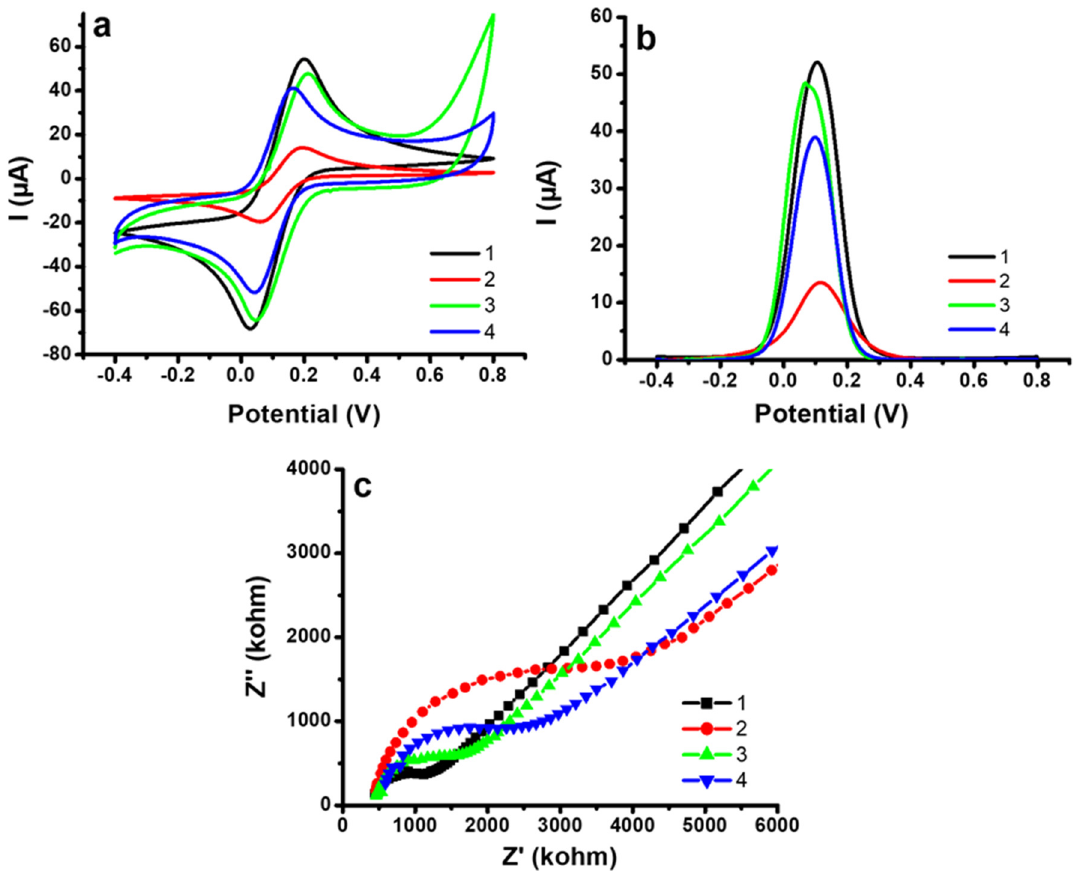
Figure 4. ( a ) CV profile, bare SPCE (1) PS/rGO-MNP-PDA (2) PS/rGO-MNP-PDA/Anti-CRP (3), and PS/rGO-MNP-PDA/Anti-CRP/CRP (4) ( b ) DPV profile, bare SPCE (1) PS/rGO-MNP-PDA (2) PS/rGO-MNP-PDA/Anti-CRP (3), and PS/rGO-MNP-PDA/Anti-CRP/CRP (4), ( c ) Nyquist profile, bare SPCE (1) PS/rGO-MNP-PDA (2) PS/rGO-MNP-PDA/Anti-CRP (3), and PS/rGO-MNP-PDA/Anti-CRP/CRP (4), (All measurements were carried out in 10 mL PBS (pH 7.4) including 0.1 M KCl and 5.0 mM HCF, [CRP] = 20 ng/mL)